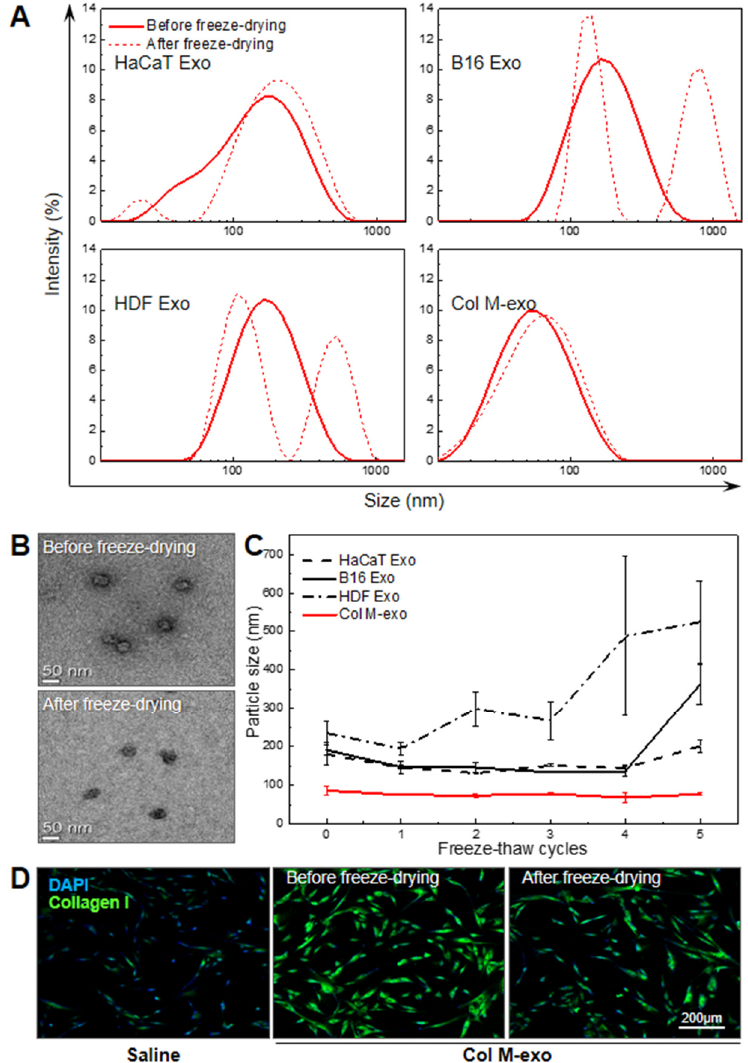
Figure 6. Structural and functional stability of Col M-exo. ( A ) Size distribution of exosomes extracted from cell-culture media and Col M-exo. Each type of exosome was compared before and after freeze-drying. ( B ) Representative TEM image of Col M-exo before and after freeze-drying. Scale bar: 50 nm. ( C ) Comparison of particle size distribution measurements of exosomes extracted from cell-culture media and Col M-exo according to freeze–thaw cycles. ( D ) Representative immunostaining images of type 1 collagen (green) in HDFs pretreated with Col M-exo before and after freeze-drying. Scale bar: 200 µ